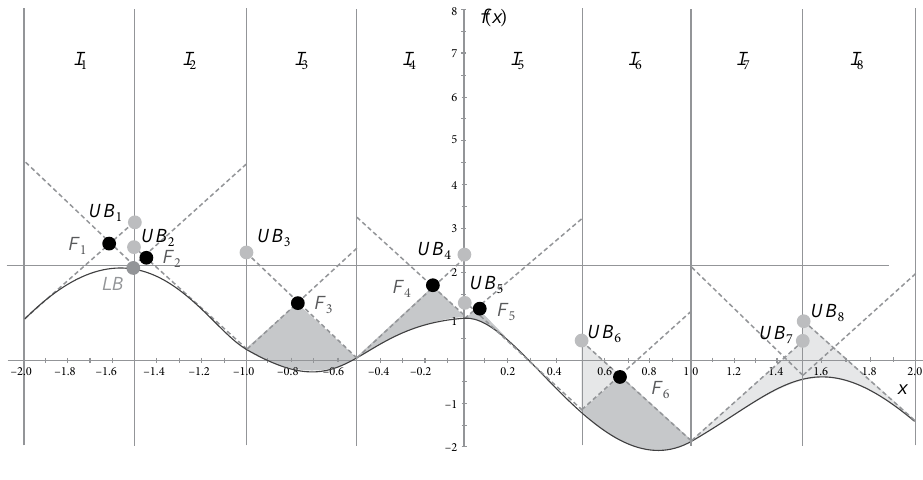
Fig. 4. Third step of branch-and-bound with simplicial partitions as n = 1